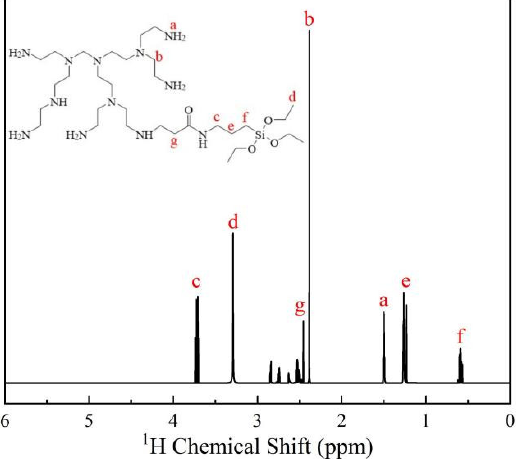
Figure 10. 1 H NMR spectrum of the organosilicon-modified PEPA.